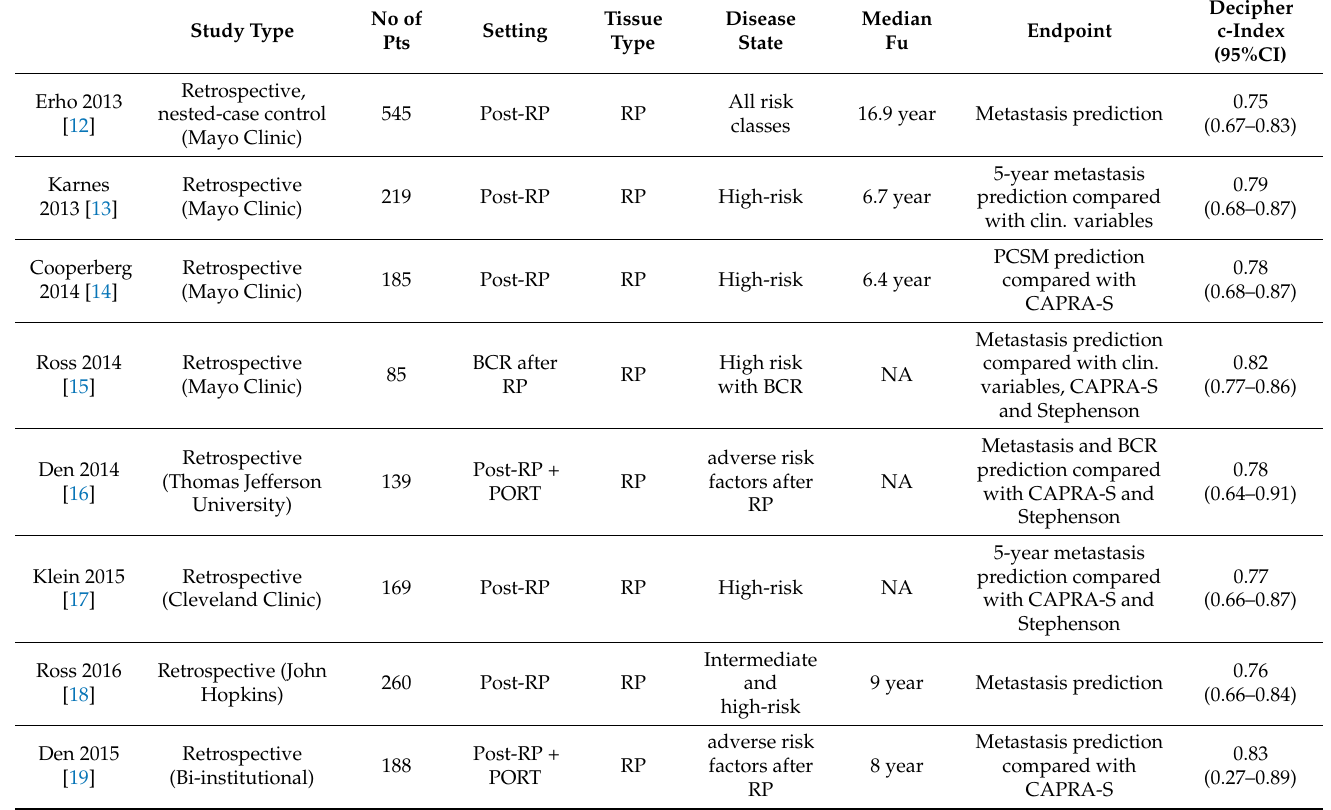
Table 2. Decipher